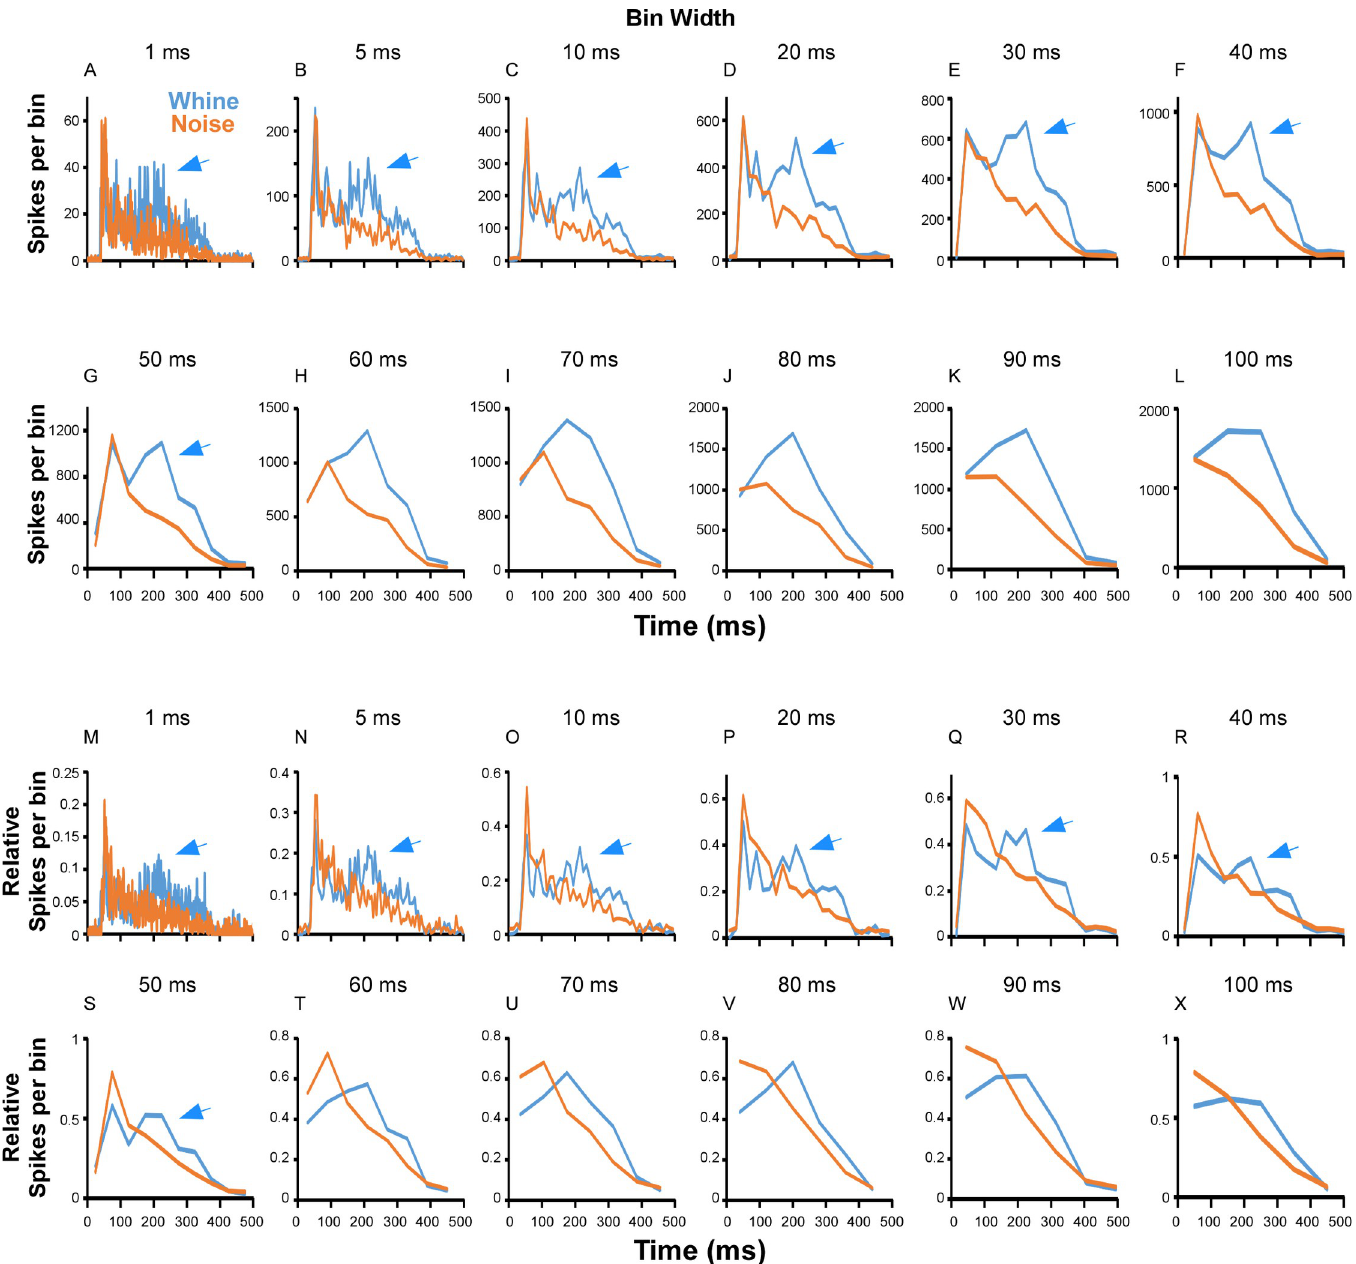
Fig 9. Effect of bin width on histogram shape. Each panel shows the peristimulus time histogram responses to the whine (blue) and noise (red) summed across cells (N = 45 cells). Bin width is noted above each panel. (A-L) Y-axis shows the number of spikes per bin. (M-X) Y-axis shows the mean relative number of spikes per bin. The mean is calculated after each cell’s histogram is normalized to its maximum bin count. After the initial burst, the increased response to the whine between ~150–250 ms (blue arrows) is evident for bin widths up to 50 ms and not an artifact of bin width.